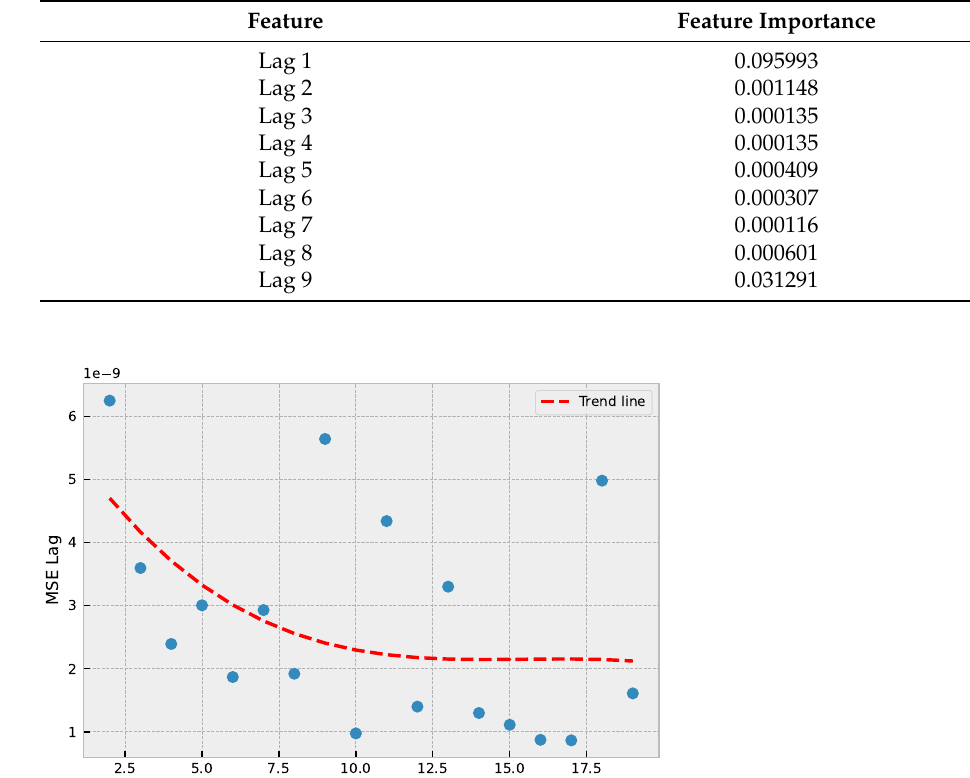
Table 4. Feature importance (input lag).